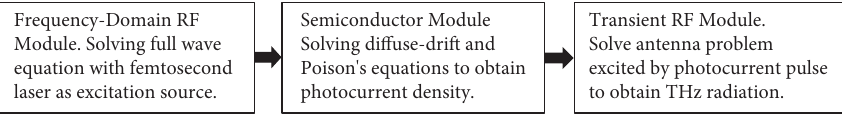
Figure 2: COMSOL multiphysics modules for PCAs